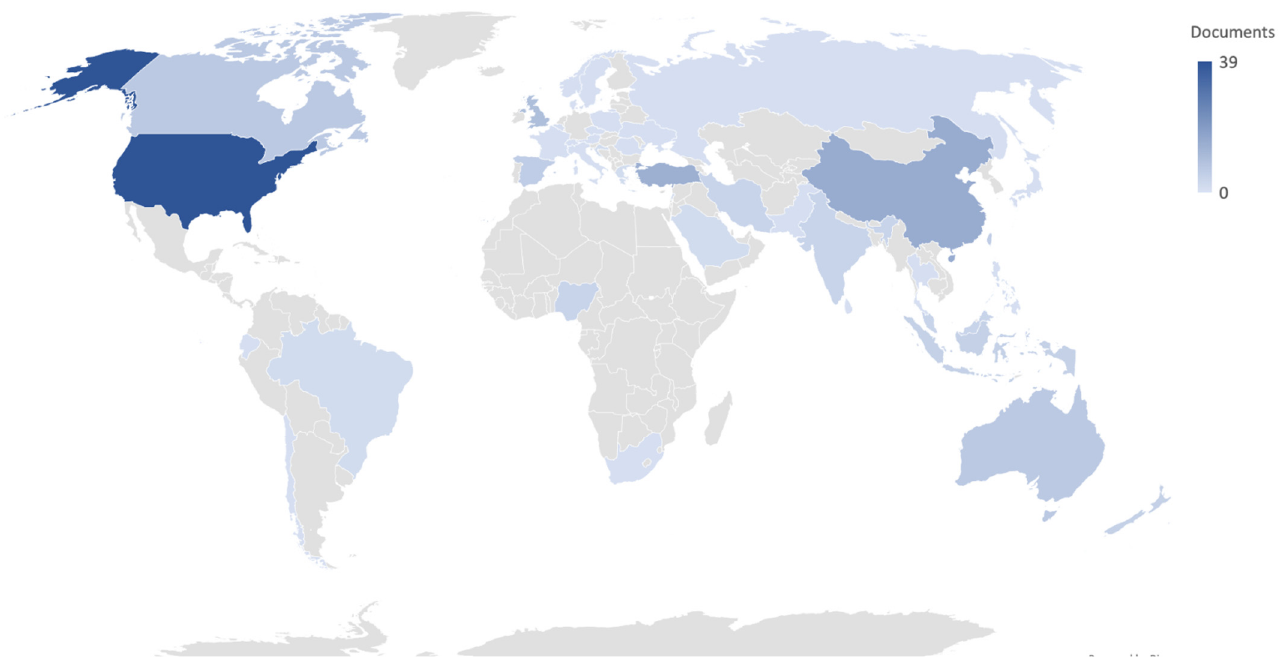
Figure 3. Distribution of the documents per country.